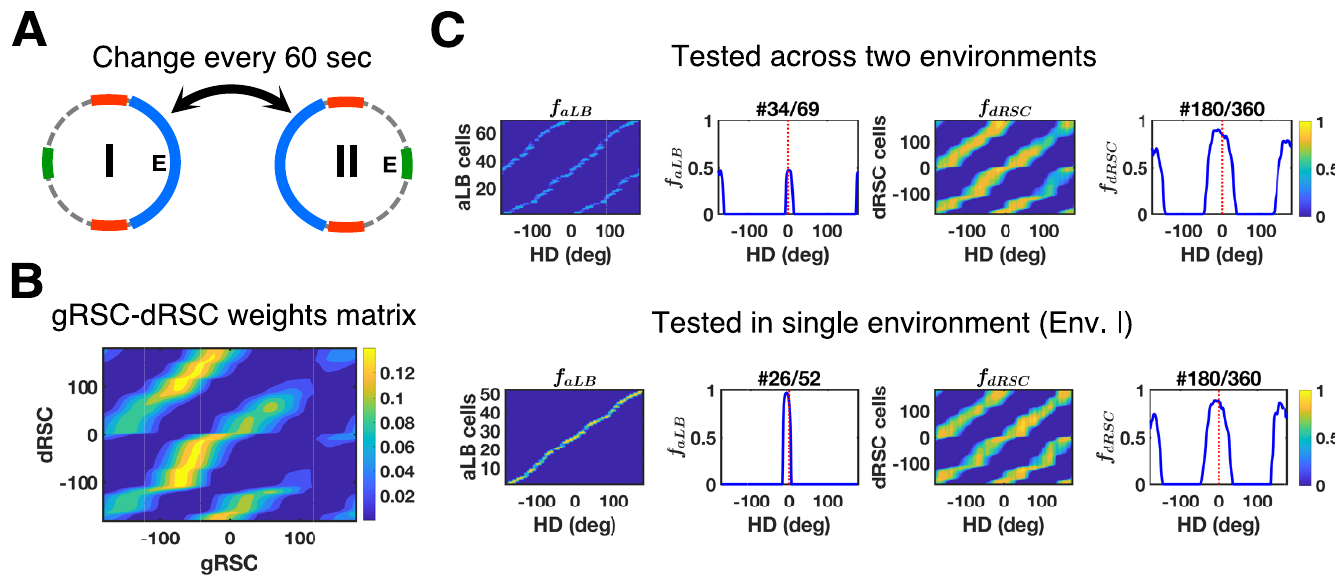
Fig 5. Mirrored environments with the simulation result in dRSC signals. (A) Illustration of the connected environments with mirrored and rotated complex sceneries. The agent repeatedly crosses from one environment to the other, spending 60 seconds in each environment at a time, for the duration of the whole 20-minute learning phase. (B) The learnt connection weights form the bimodality of dRSC responses after the whole learning phase. (C) Global representations of aLB cells (left, with a single cell example) and dRSC cells (right, with a single cell example) after learning, tested in alternating environments (top, row; 10 seconds in each environment) or in a single environment (Env. I, bottom row). Note that aLB cells are unimodal within a given environment (bottom left), contrary to WC-BD cells. aLB cells are labelled as positive numbers, whilst other cells are labelled from -180 to 179 according to their own initial preferred directions (y-axis). The x-axis stands for HD. Abbreviations: aLB: abstract landmark bearing; gRSC/dRSC: granular/dysgranular retrosplenial cortex; HD: head direction; f : firing